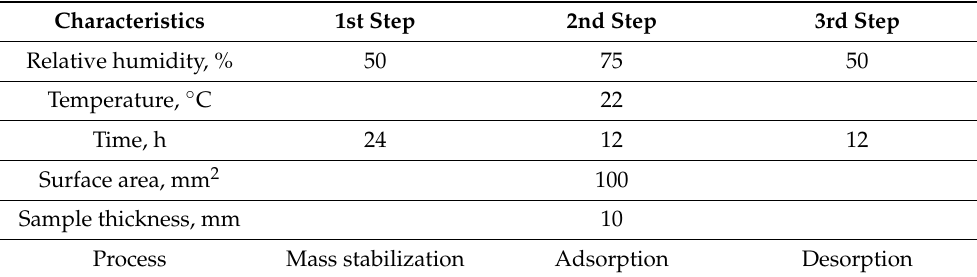
Table 3. Methodology of moisture buffering capacity